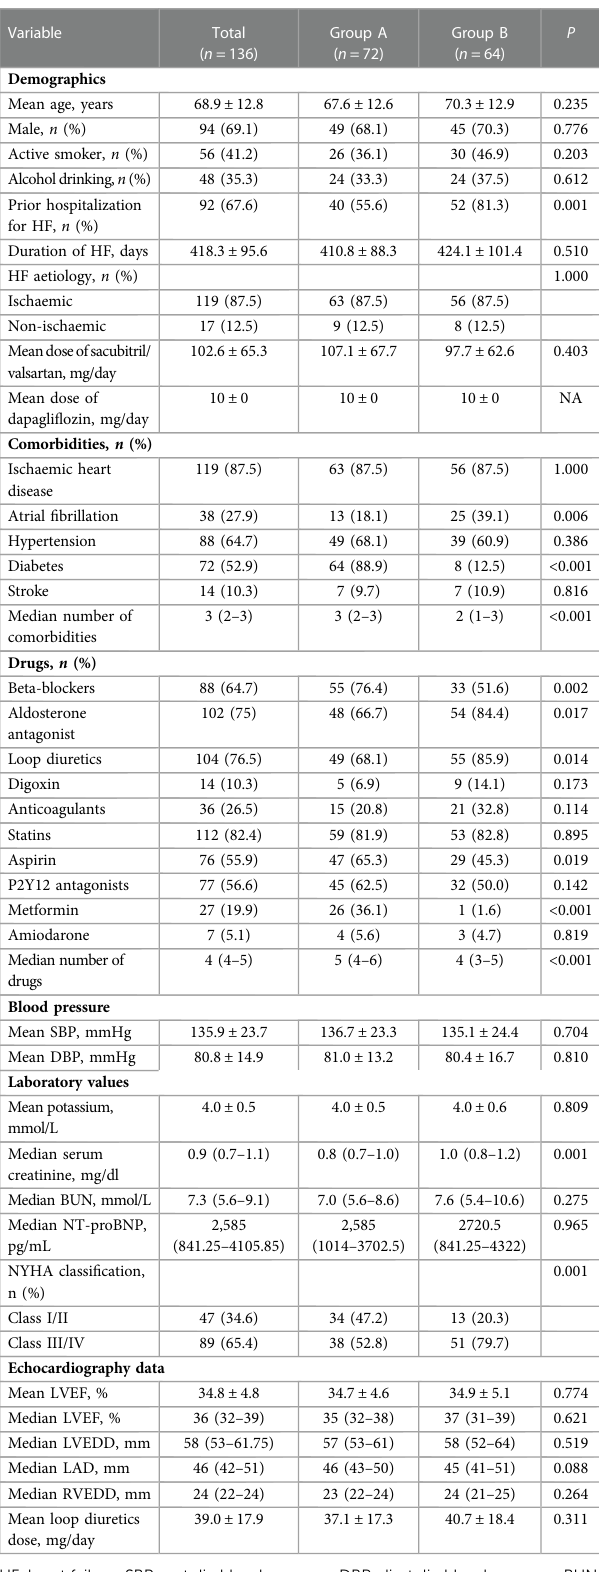
TABLE 1 Baseline characteristics of enrolled